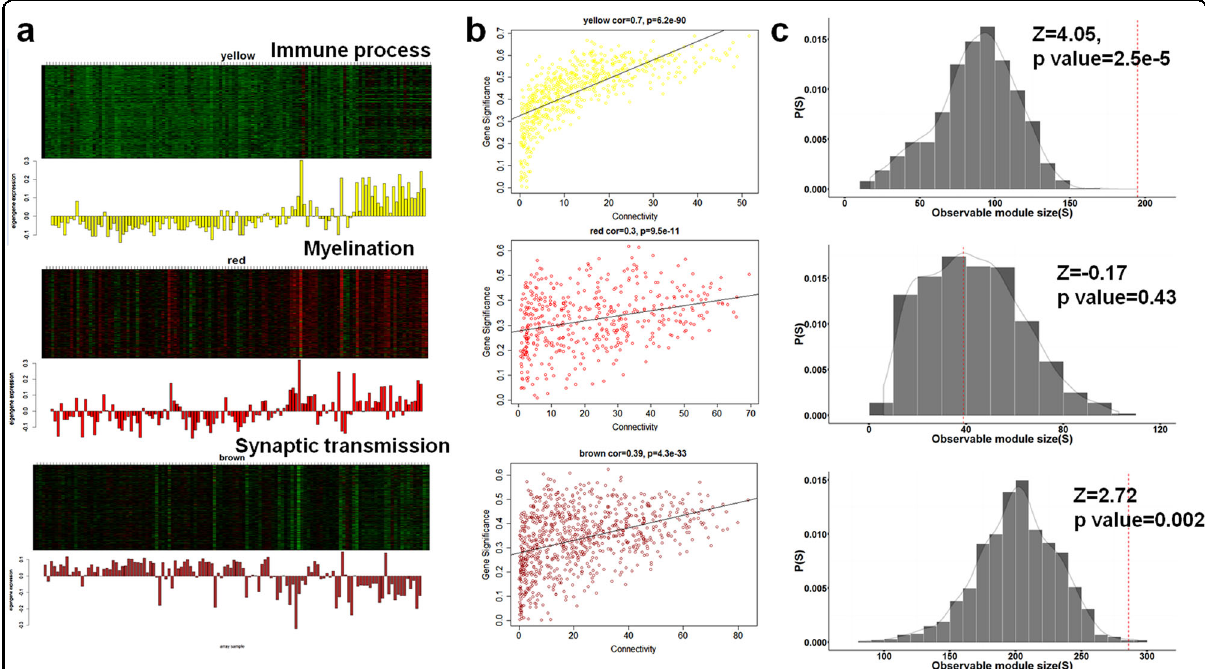
Fig. 3 Co-expression network analyses on brain aging. a Three co-expression modules in the aging hippocampus were highly correlated with age in gene expression (positive correlation for genes associated with immune and demyelination; negative correlation for those with synaptic transmission). Each bar graph corresponds to an eigengene (representative expression of each module, left panel). b Linear regressions between intramodular connectivity and gene signi fi cance (the extent of correlation with aging). c The observed number of physically connected genes (in the interactome) in each co-expressed module was compared with that of randomly generated modules. From top to bottom, yellow, red, and brown modules were displayed. Yellow module was enriched in immune process, red in myelination and brown in synaptic